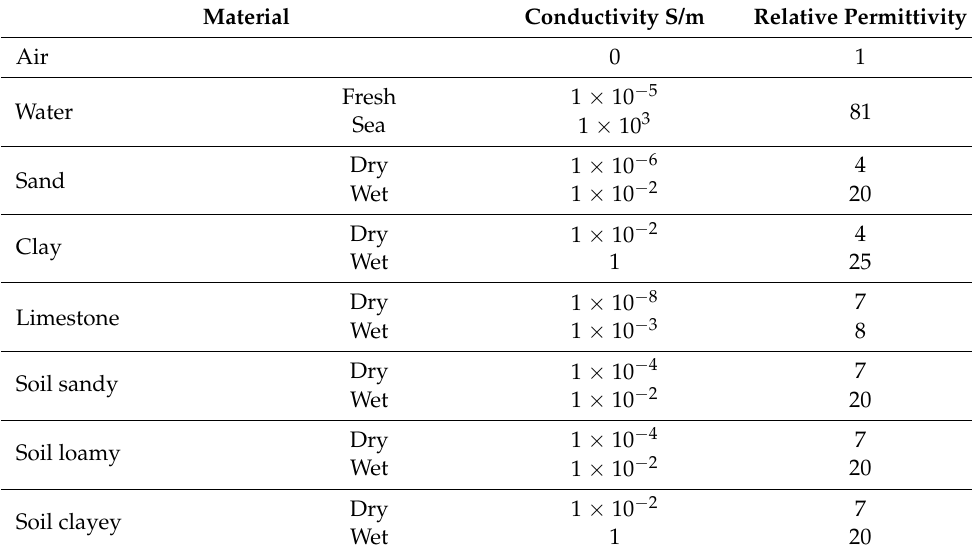
Table 3. Typical range of electrical characteristics of different materials. Material Conductivity